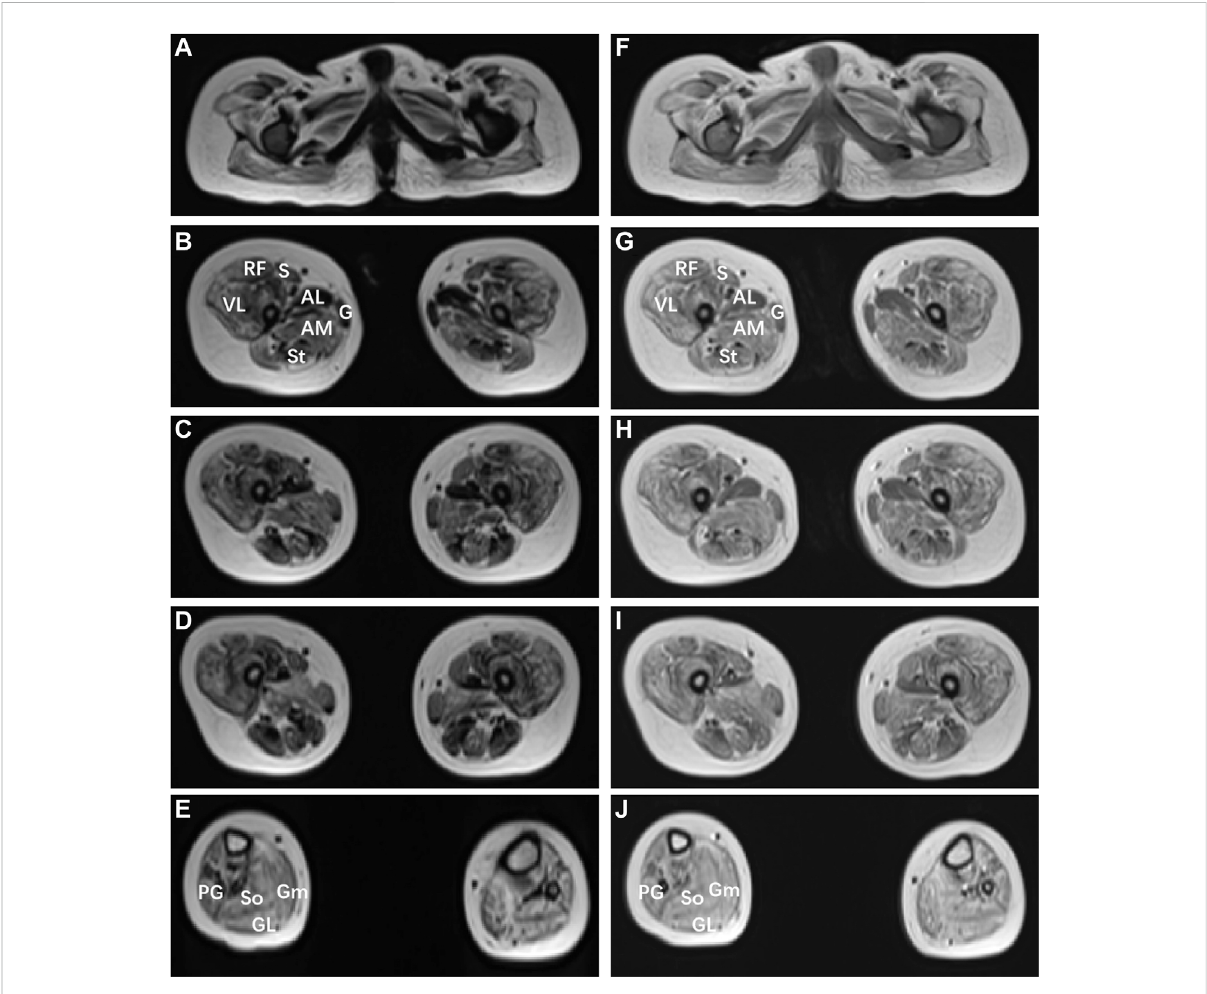
FIGURE 2 Muscle MRI fi ndings of the patient with MSTO1 variant. Muscle MRI images of the short T1 signal shadow, uneven T2WI signal in muscle groups of both lower limbs (A – E) , and uneven enhancement was observed after enhancement (F – J) . The patient shows marked involvement of the glutei within the pelvis (A,F) , within the thigh (B – D) ; (G – I) , the pattern of involvement was diffuse, with relative sparing of gracilis (G) compared to sartorius (S),andadductorlongus(AL)comparedtoadductormagnus(AM).VL:vastuslateralis;S:soleus;Gm:gastrocnemiusmedialis,Gl:gastrocnemius